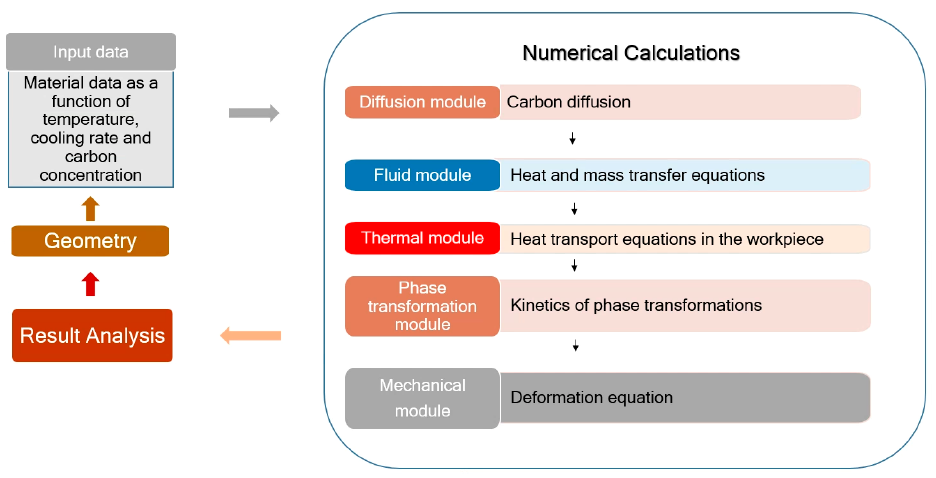
Figure 2. Numerical simulation algorithm.